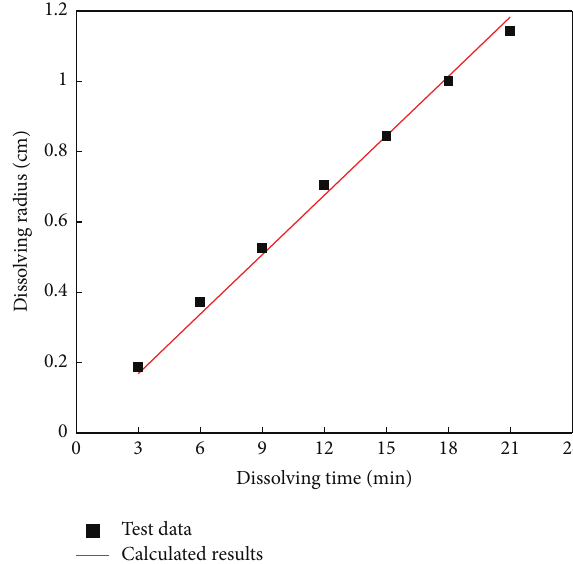
Figure 9: Comparison of the dissolved radius between test data and calculated results under 30 L/h.